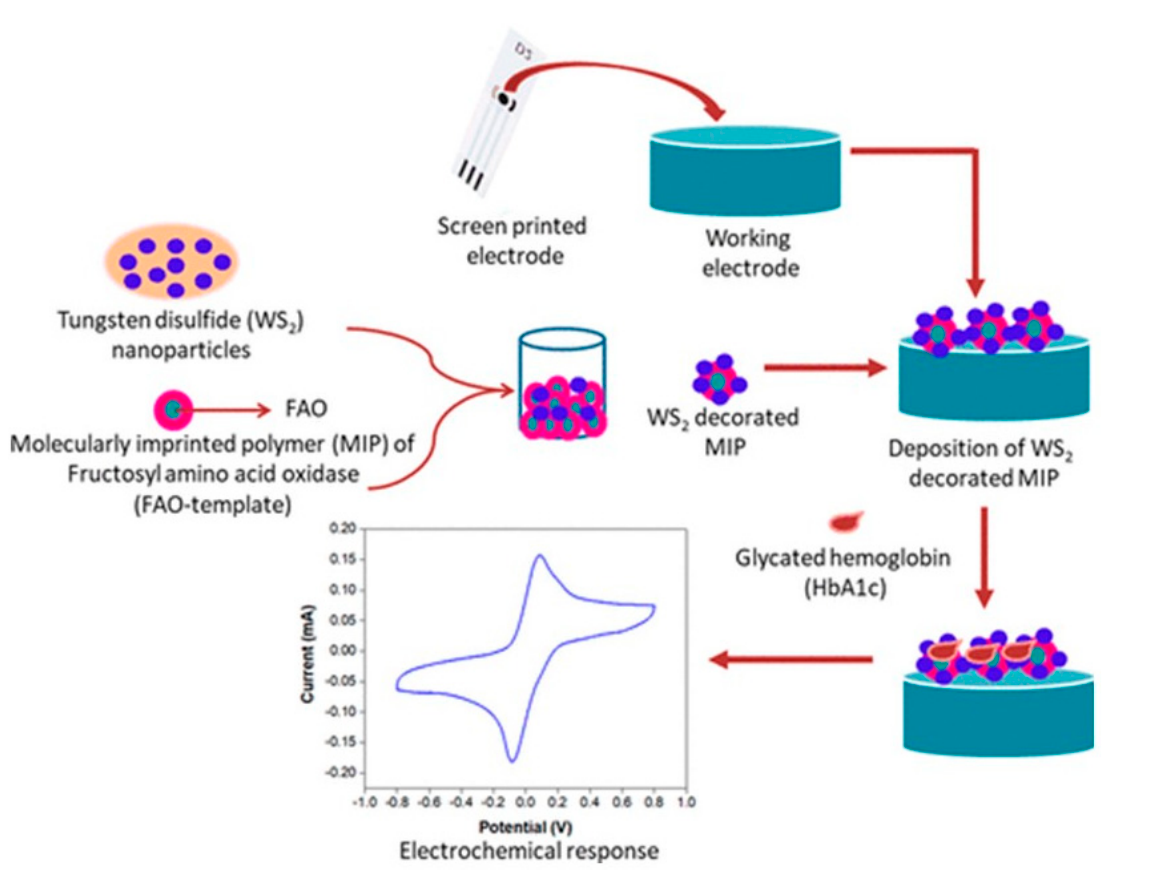
Figure 9. Schematic illustration of a WS 2 NP − fabricated nano-biosensor based on the FAO principle for the HbA1c sensor in diabetic patients. Copyright CC BY − NC − ND 4.0 [86].